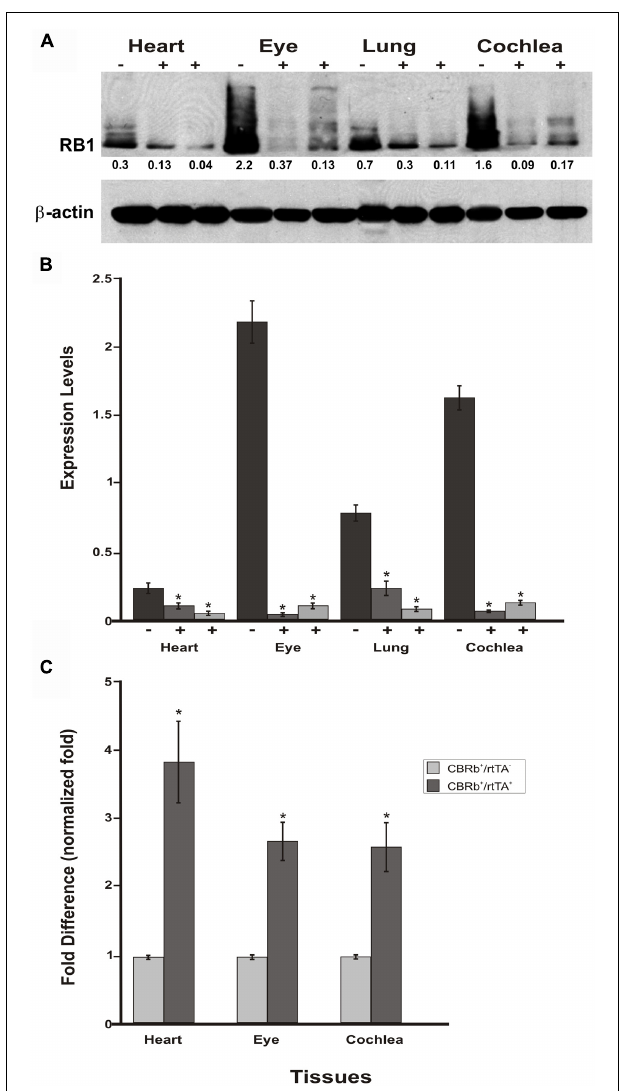
FIGURE 9 | Spatial analyses of the DN-CBRb transgene activation in P18 DN-CBRb + / ROSA-CAG-rtTA + and DN-CBRb + / ROSA-CAG-rtTA − mice heart, eye, lungs, and cochlea. (A) Confirming efficiency of Dox-mediated transgene activation, expression of the endogenous RB1 was downregulated in the CBRb + / ROSA-CAG-rtTA + ( + ) tissues, but not in the CBRb − / ROSA-CAG-rtTA + ( − ) control mice tissues. Densitometric analysis was performed as described in Figure 4 .The relative RB1 expression levels are shown underneath each blot. (B) Graphic representation of normalized RB1 expression levels plotted against the different tissues. Inter-individual variation on endogenous RB1 levels may explain differences in individual responses to transgene activation and RB1 downregulation. (C) RT-PCR analyses in eye, heart and cochleae revealed significant upregulation of the DN-CBRb transcript in dox-treated DN-CBRb + / ROSA-CAG-rtTA + tissues, but not in DN-CBRb + / ROSA- CAG-rtTA − . CBRb + /rtTA + = DN-CBRb + / ROSA-CAG-rtTA + ; CBRb − / rtTA + = DN-CBRb − / ROSA-CAG-rtTA + ; CBRb + /rtTA − = DN-CBRb + / ROSA-CAG-rtTA − . * P < 0.05.